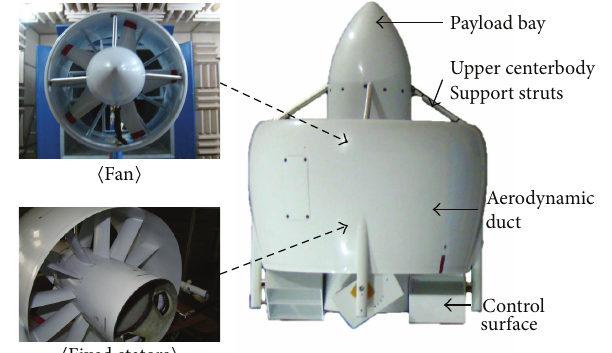
Figure 2: A configuration of the CNU ducted-fan UAV.